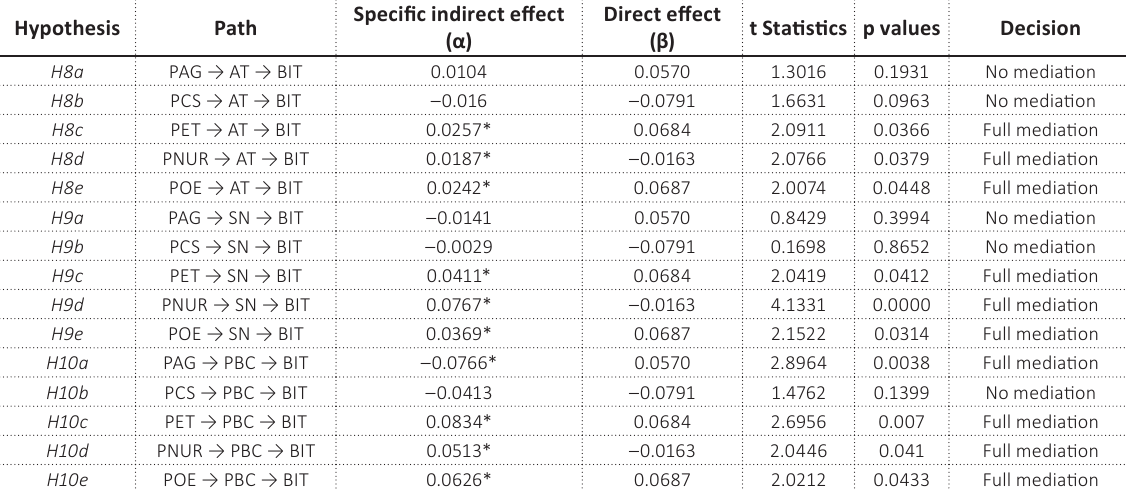
Table 7. Mediation